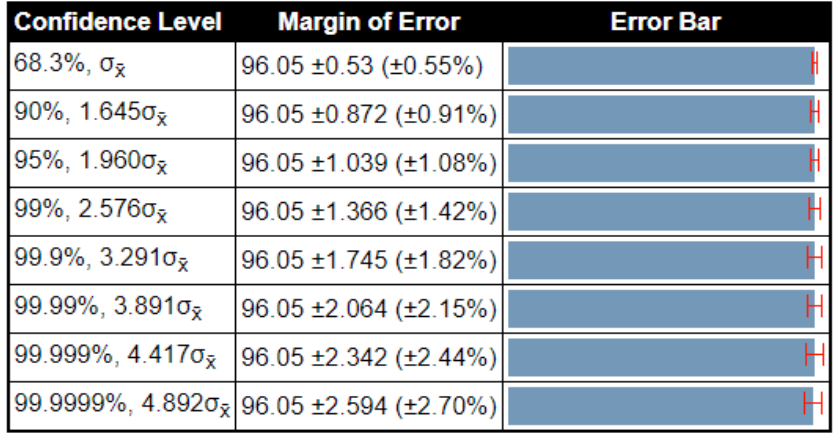
Figure 17. Confidence interval based analysis of proposed method on real-time dataset.